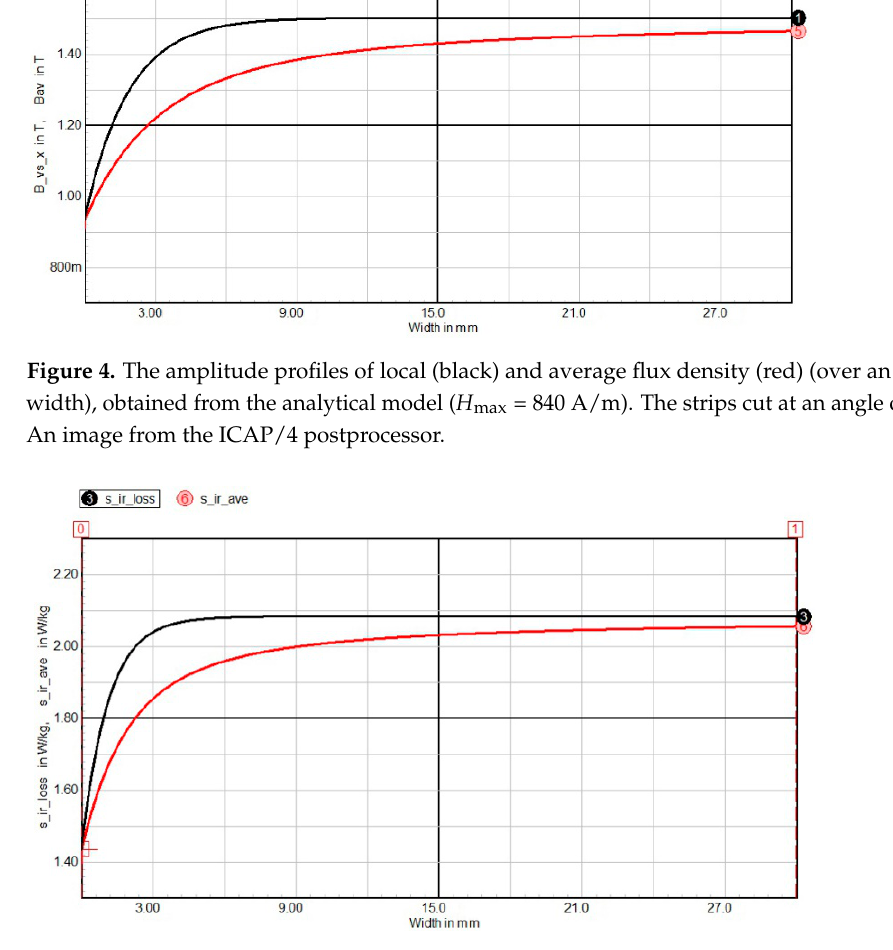
Figure 5. The profiles of local (black) and average specific iron loss (red) (over an actual strip width), obtained from the analytical model ( H max = 840 A/m, 50 Hz). The strips cut at an angle of 0 degrees. An image from the ICAP/4 postprocessor.